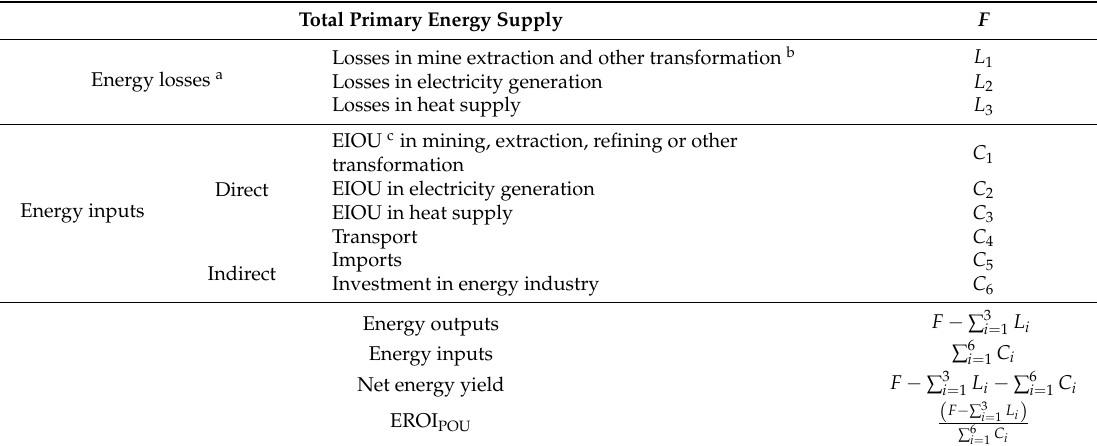
Table 1. Example calculation of the EROI POU values of China’s fossil fuels (units: